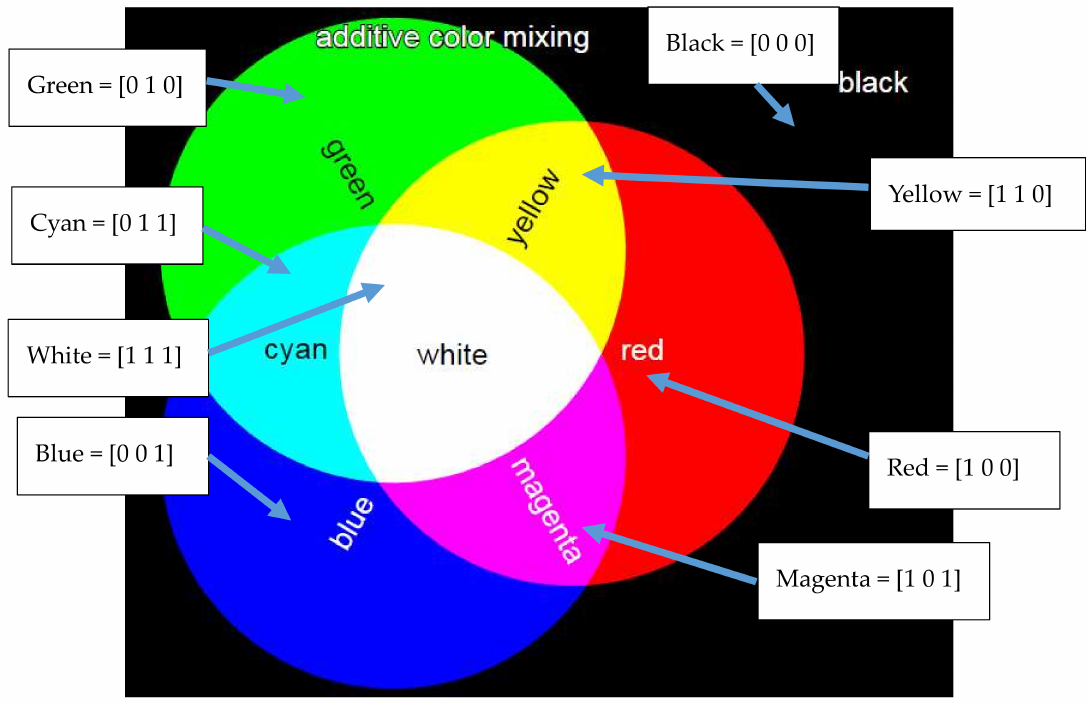
Figure 1. 3-bit additive color